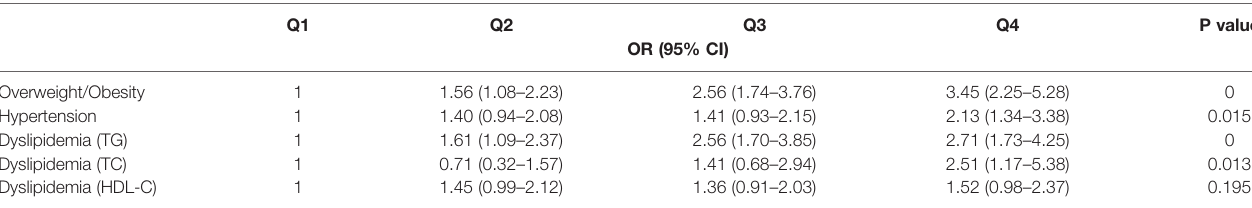
TABLE 4 | Association of SUA quartiles with MetS components.